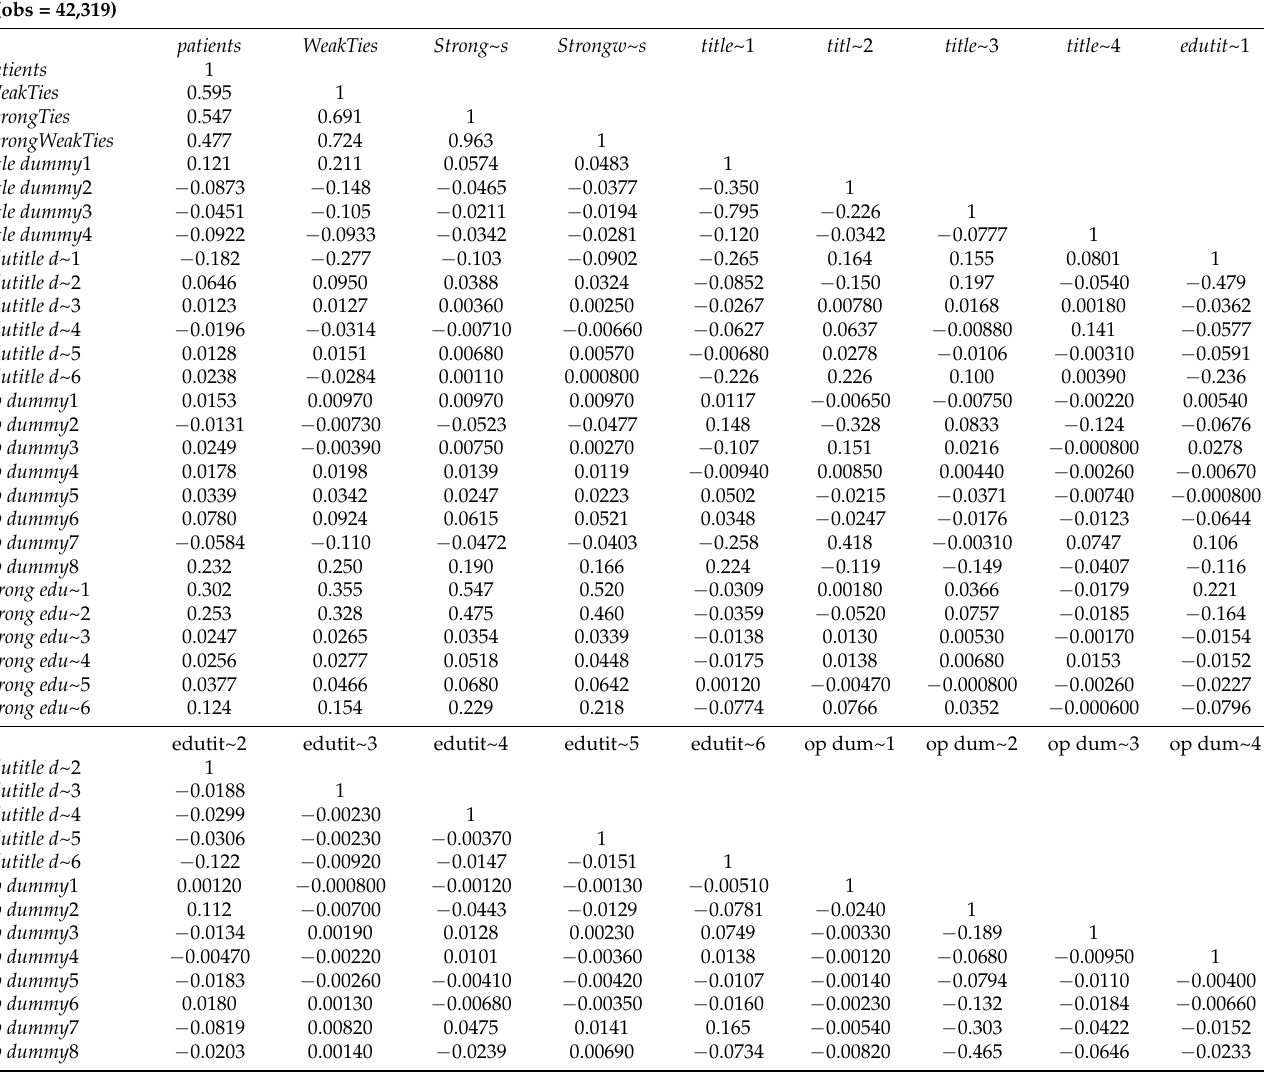
Table 3. Correlations of the